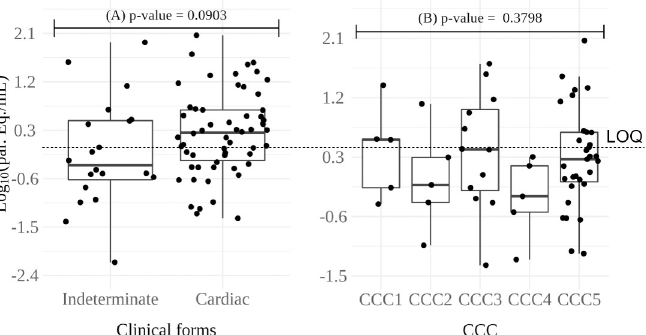
Fig 3. Boxplots of parasite load of chronic Chagas disease patients. (A) Patients with clinical forms, indeterminate or cardiac, and p-value of the Mann-Whitney-Wilcoxon test. (B) Patients presenting chronic Chagas’ cardiomyopathy (CCC to 5) in different degrees of cardiac involvement and p-value of the Kruskal-Wallis test. Par. eq./mL: parasite equivalent per milliliter of blood, CCC1 to 5: different degrees of cardiac involvement. LOQ: Limit of Quantification [25].